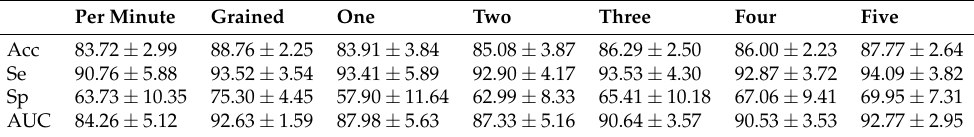
Table 5. Overview of the performances of the SVM models on the test folds. The results are shown as mean ± standard deviation. One, Two,..., Five indicate the performance of the SVM model with the inclusion of the highest, second highest,..., fifth highest ranked features. The overall highest AUC is obtained when the model is trained with the five highest ranked